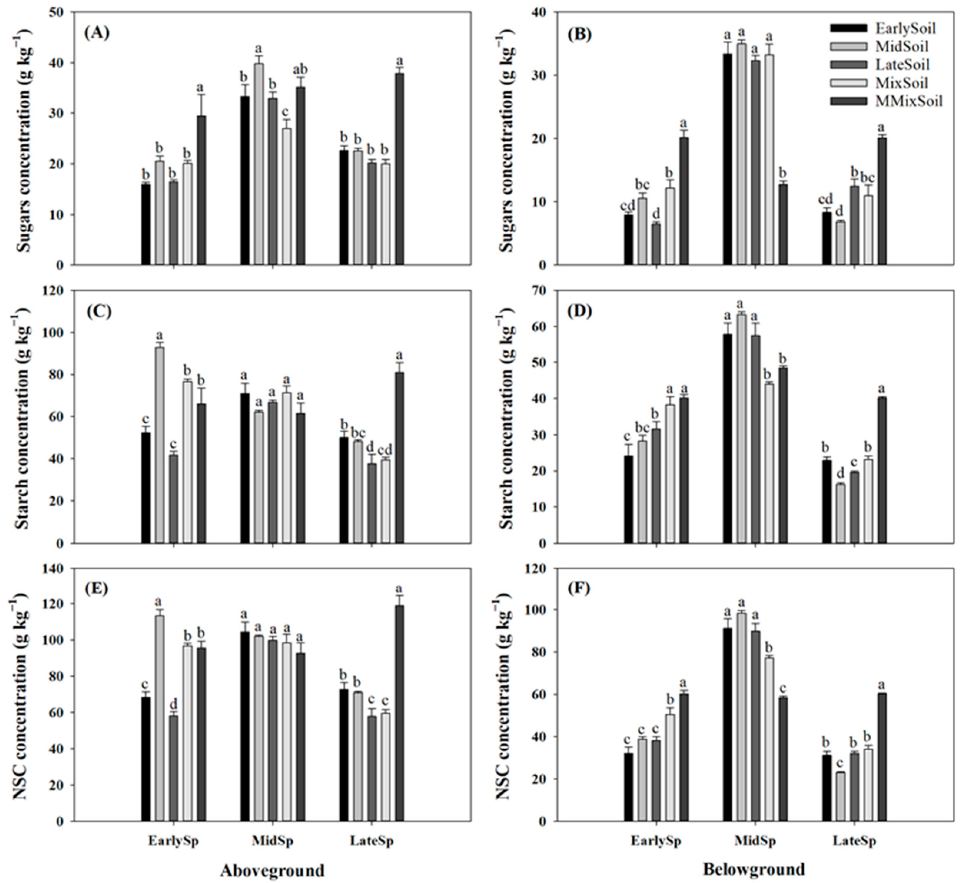
Figure 4. Effects of soil feedback on soluble sugars ( A , B ), starch ( C , D ), and NSC ( E , F ) concentrations in above- and belowground organs of early-, mid-, and late-successional species. Error bars are standard errors ( n = 4). Different letters above the bars indicate significant differences at p < 0.05.